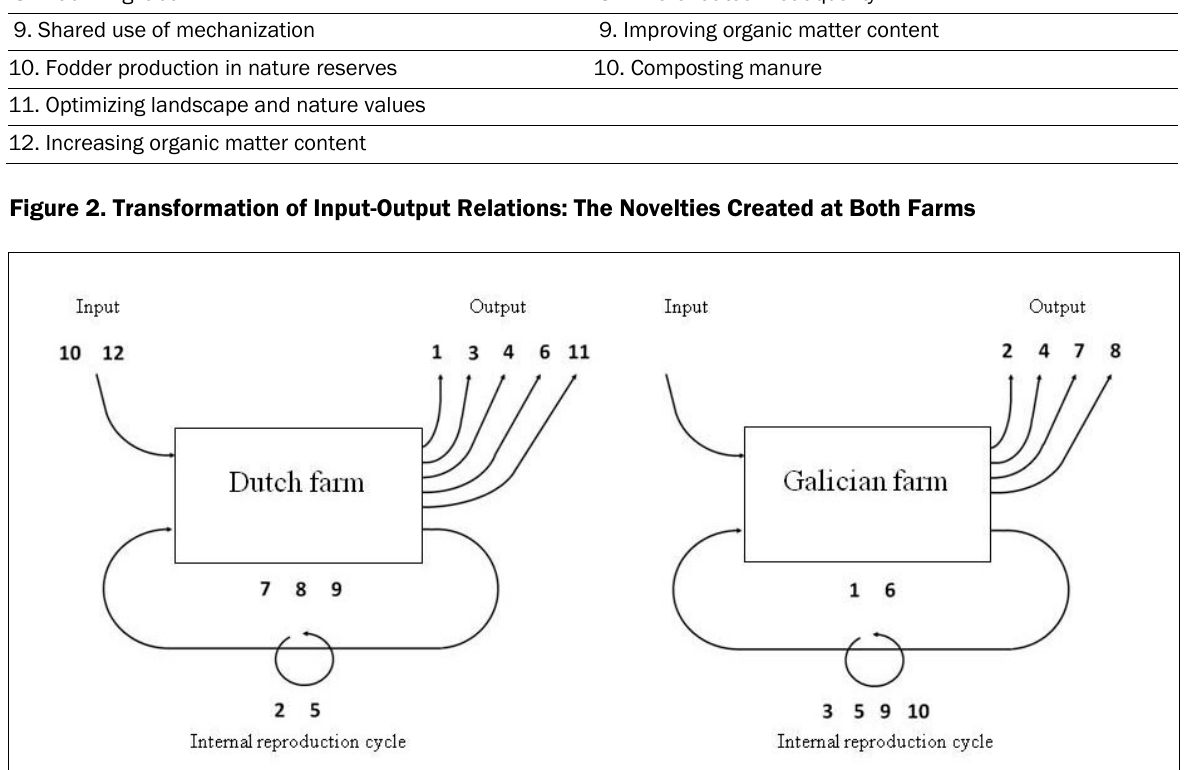
Source: Adapted from van der Ploeg (2008, p.